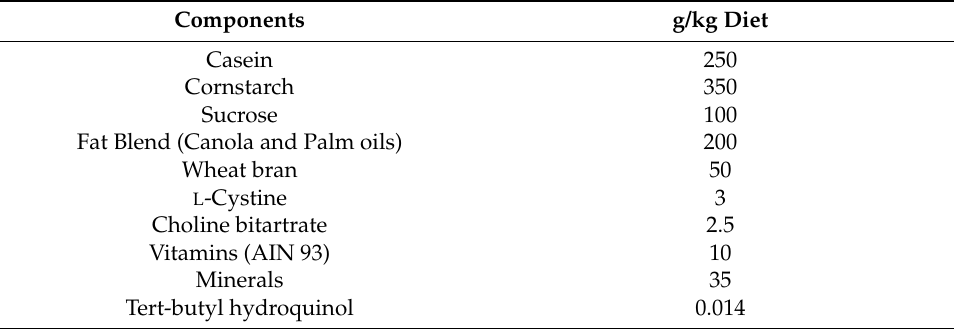
Table 1. Composition of control (Western)